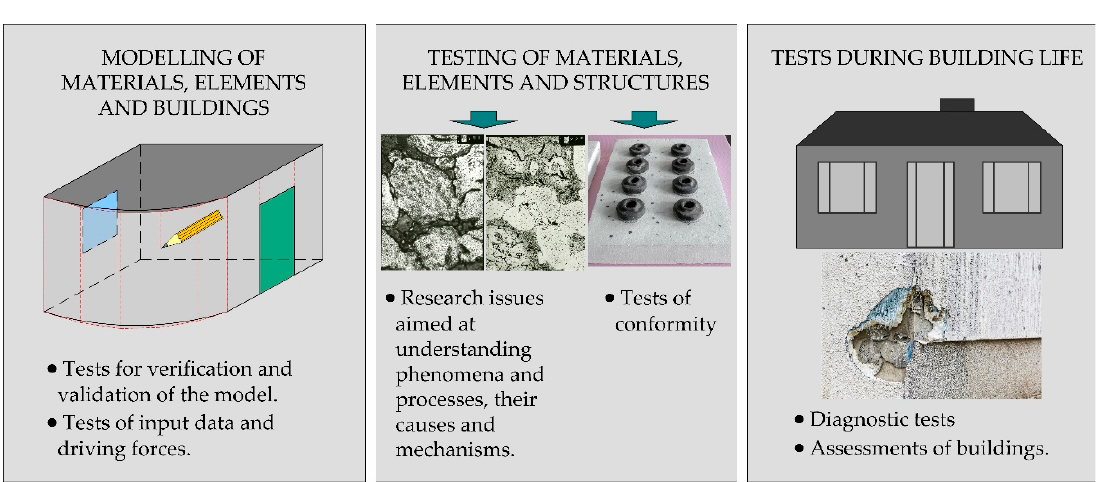
Figure 1. Presence of tests at all stages of the creation and life of buildings.